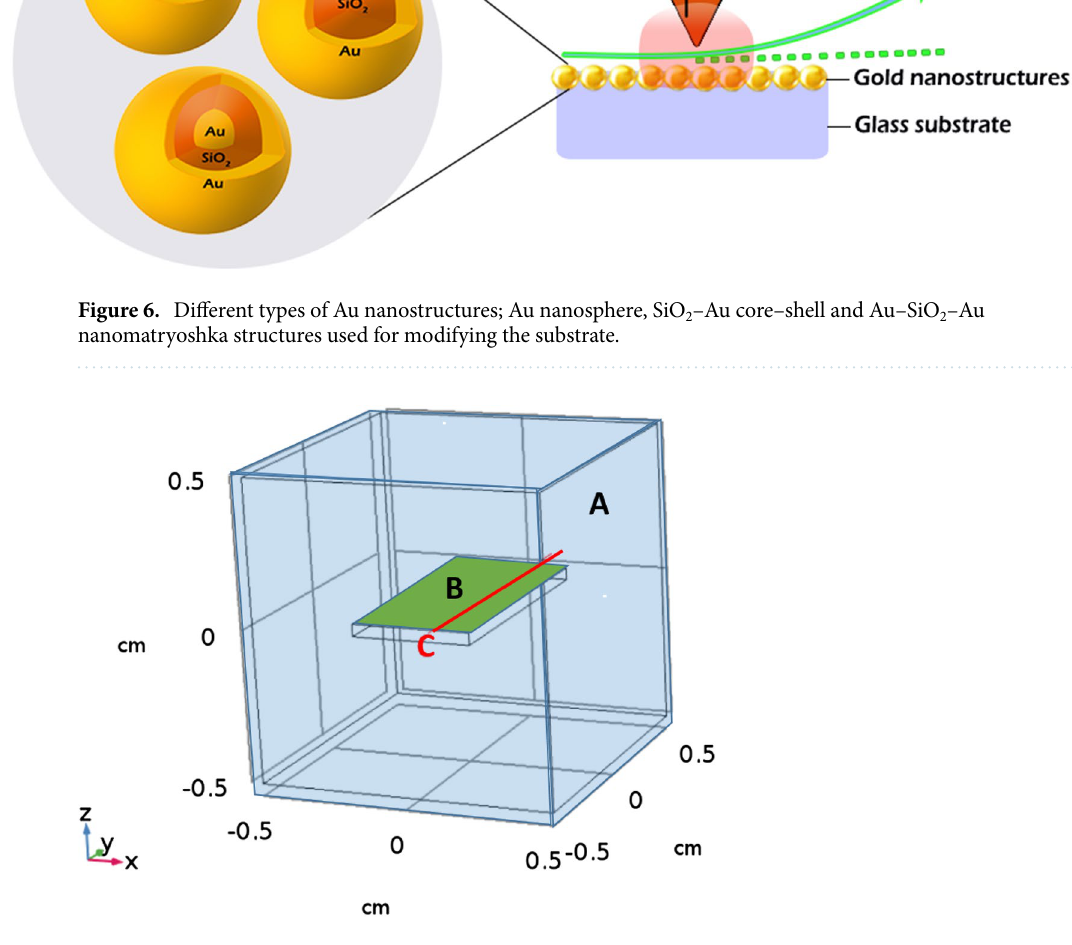
Figure 7. The geometrical structure of the model for the BDS system for detection of H 2 S gas. (A) Shows the H 2 S gas container (blue color), (B) shows the surface of substrate including the Au NPs (green color), and (C) demonstrates the cut line exploited for temperature variation (red